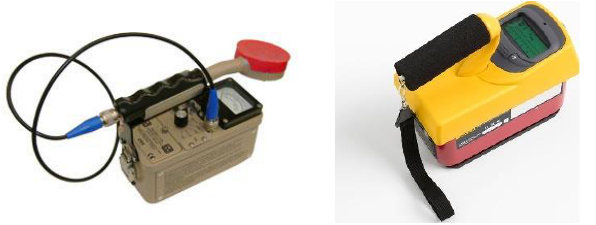
Figure 2. Examples of radiation survey meters used in radiation monitoring. Table 3. The equivalent dose limit for specific body parts was proposed by the ICRP [72].